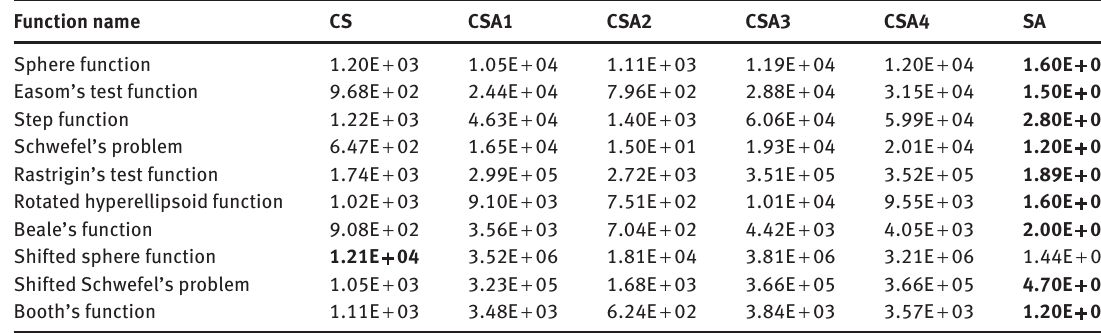
Table 6: Comparison of the Running Time of all the Variations of CSA to the Running Time of CS and SA. Function name